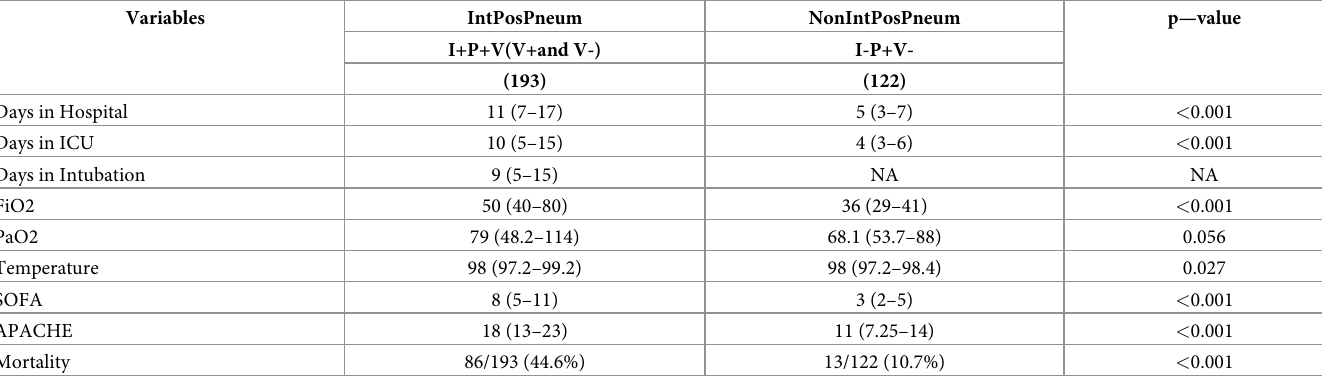
Table 2. Kruskal-wallis rank sum test for the variables associated with intubation and